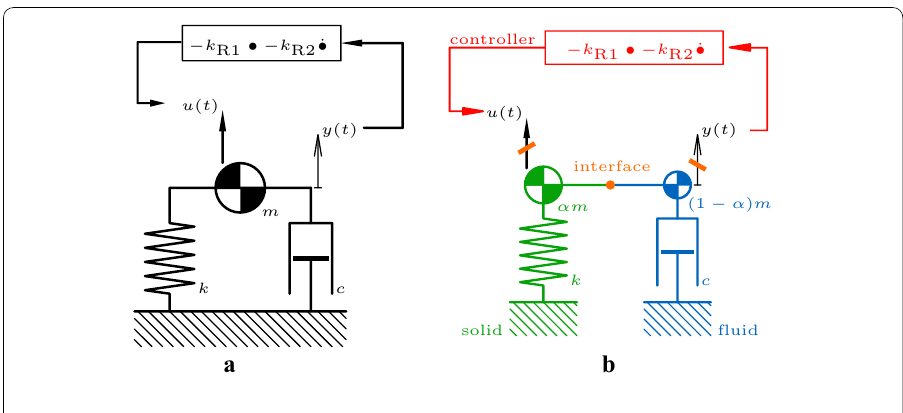
Fig. 1 Simplified model problem: a Monolithic, b